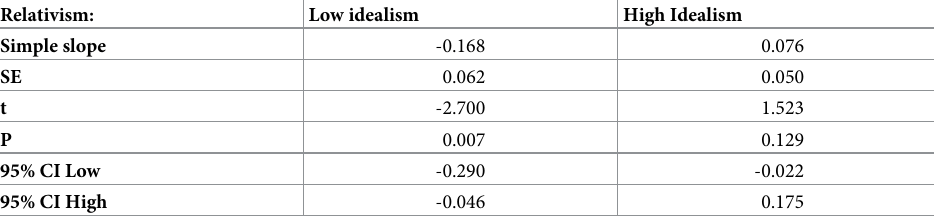
Table 8. Tests of simple slopes of regression for interaction between idealism and relativism in the prediction of environmental judgement.